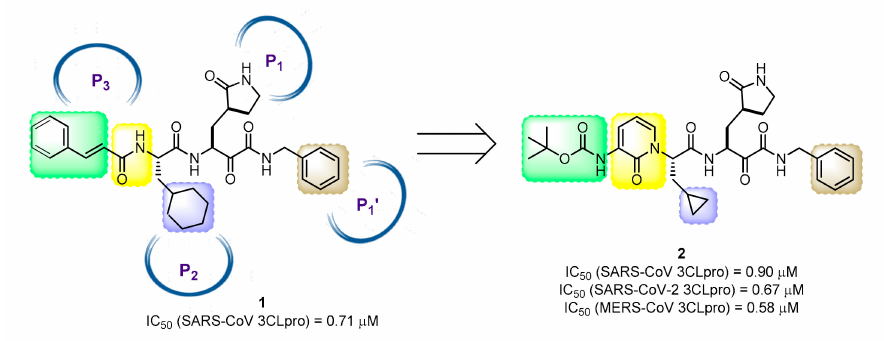
Figure 11. Structure of α -ketoamide-based broad-spectrum 3CL pro inhibitors 1 and 2